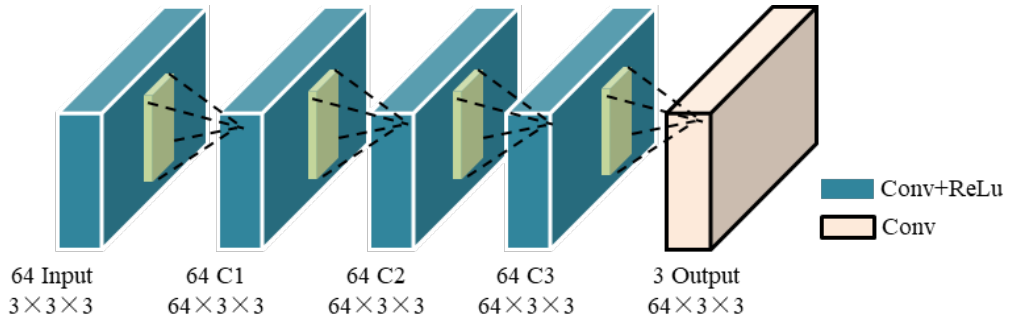
Figure 3. The framework of the OCC